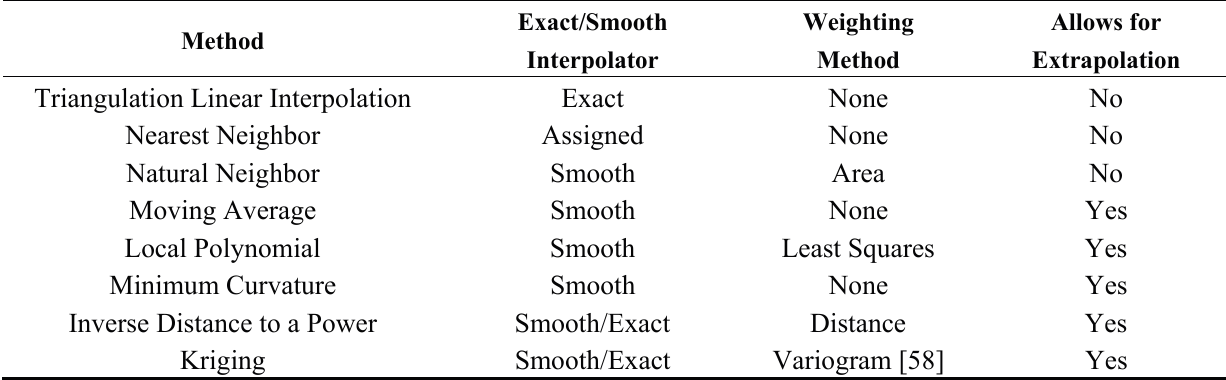
Table 3. Characteristics of main surface interpolation